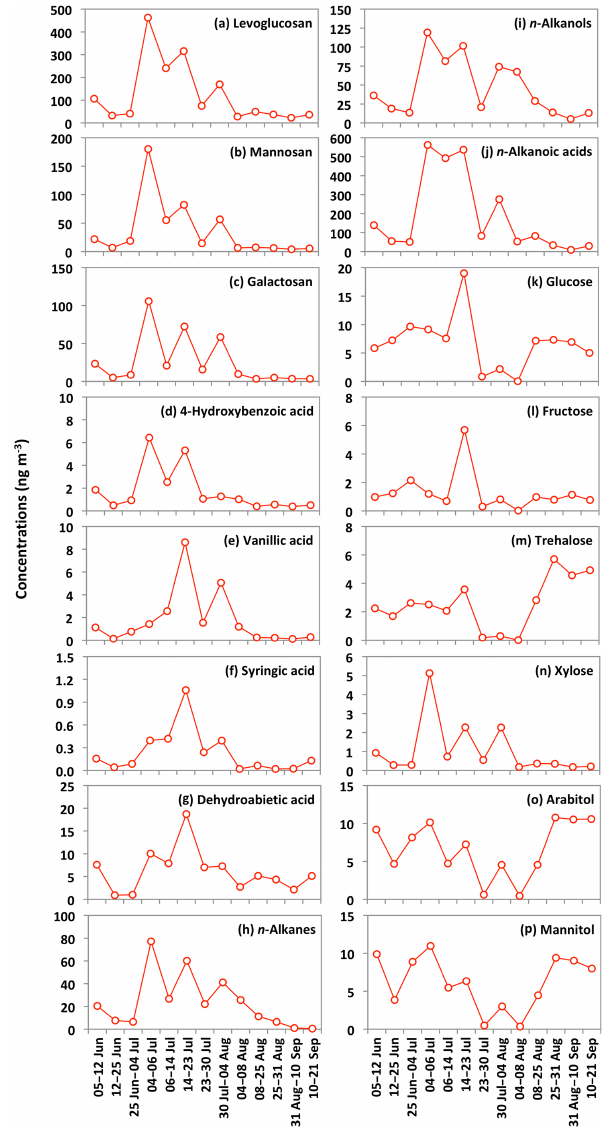
Figure 6. Temporal changes in the concentrations of biomass burn- ing tracers and other organic compounds in the Alaskan aerosols.